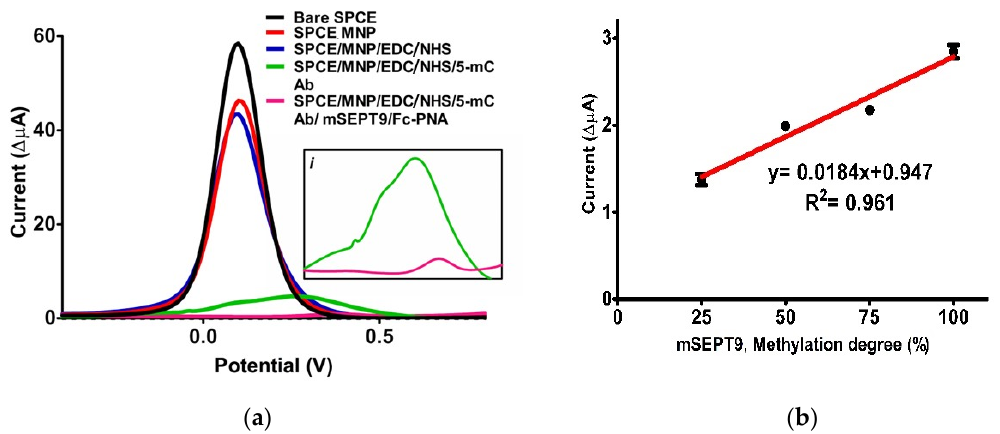
Figure 4. ( a ) DPV results of biosensor [Measurements for SPCE/MNP/EDC/NHS/5-mC Ab/and SPCE/MNP/EDC/NHS/5-mC Ab/Fc-PNA were shown in the inset (i)]. [Electrochemical cell containing 0.1 M KCl and 5.0 mM HCF in 1X PBS buffer (pH 7.4) was used for measurements of Bare SPCE; SPCE/MNP; SPCE/MNP/EDC/NHS; SPCE/MNP/EDC/NHS/5-mC Ab steps. The electrochemical cell containing 0.1 M KCl in 1X PBS buffer (pH 7.4) was used for the measurement after addition of